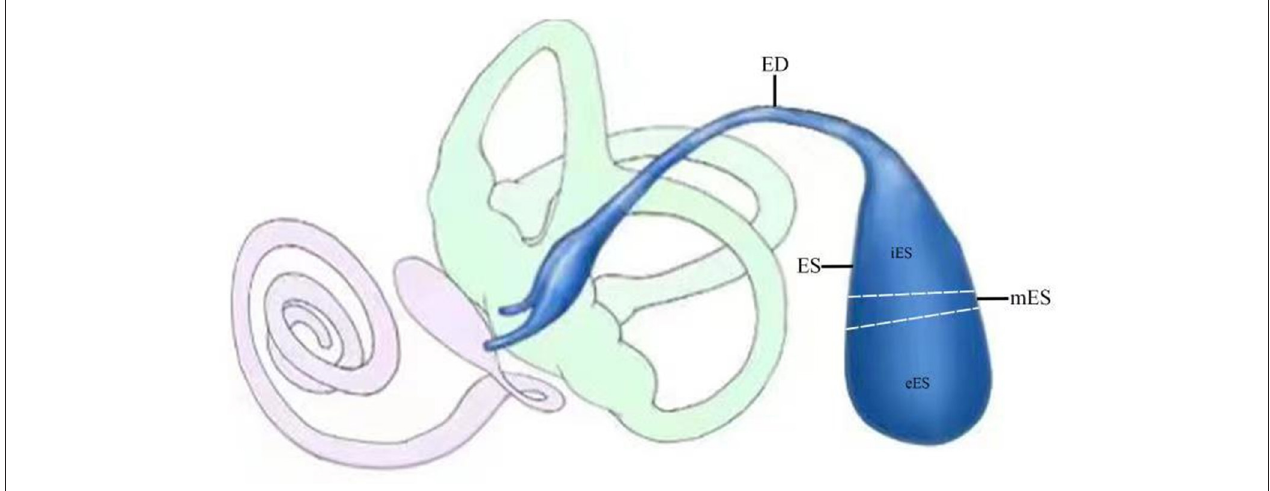
FIGURE 1 | Schematic illustration of endolymphatic sac (ES; blue) and duct (ED; blue) and its relationship to the cochlea (pink) and the vestibule (light green). The sac can be divided into extraosseous (eES), intermediate (mES) and intraosseous (iES)